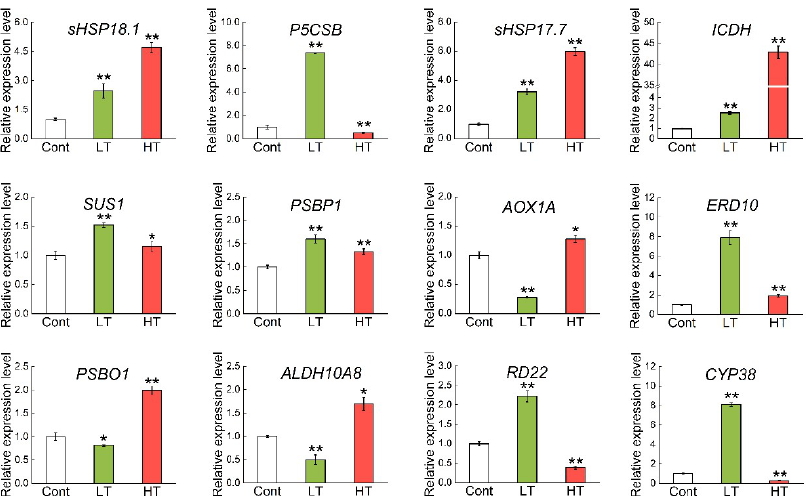
Figure 6. Gene expression related to upregulated differentially expressed proteins (DEPs) in leaves of plants subjected to LT and HT. Actin was used as the internal control to calculate the relative expression level. Data shown here are mean ± standard deviation (SD) of 3 biological replicates. ** Significant di ff erence at p <